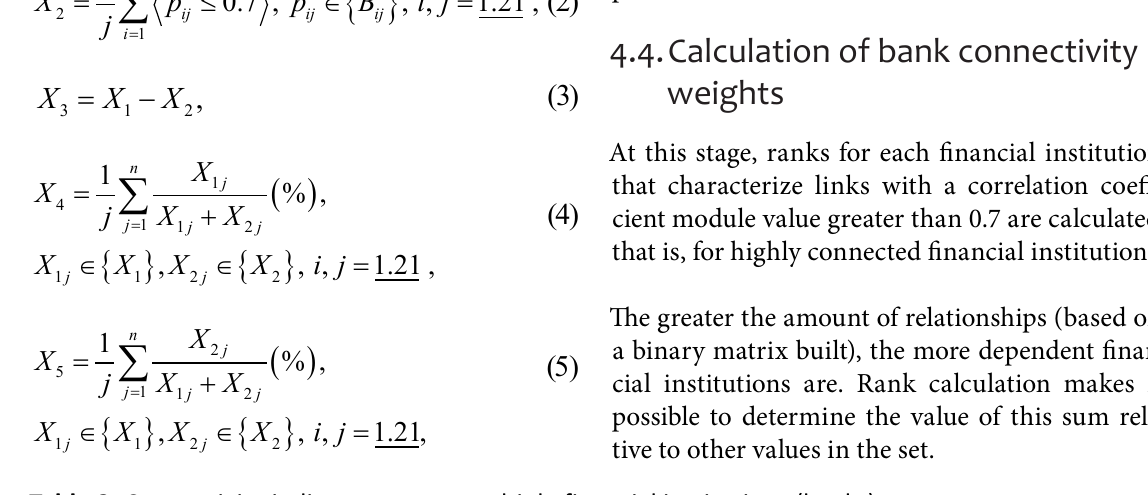
Table 2. Connectivity indicators across multiple financial institutions